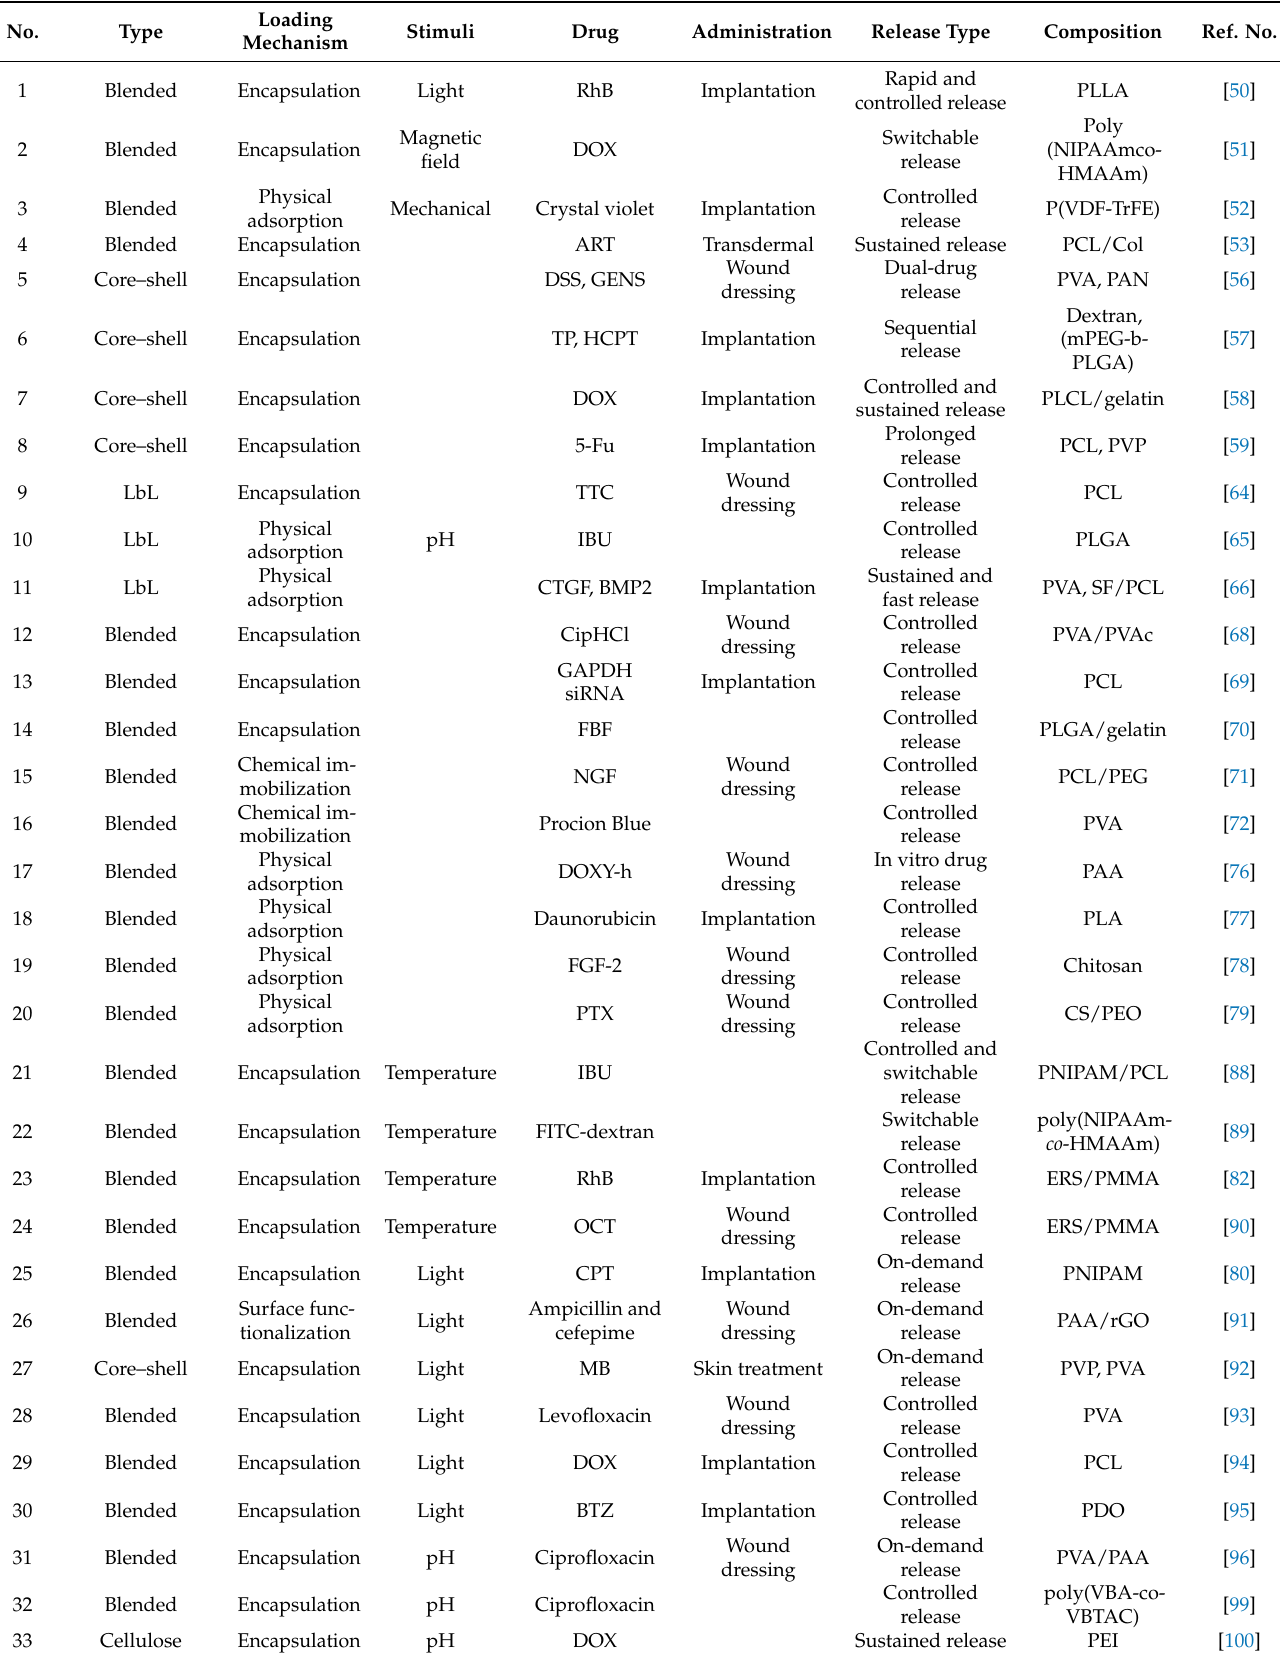
Table 1. Types, drug loading mechanism, drug administration, stimuli and release types, and composition of